Question: What form of chart is displayed?
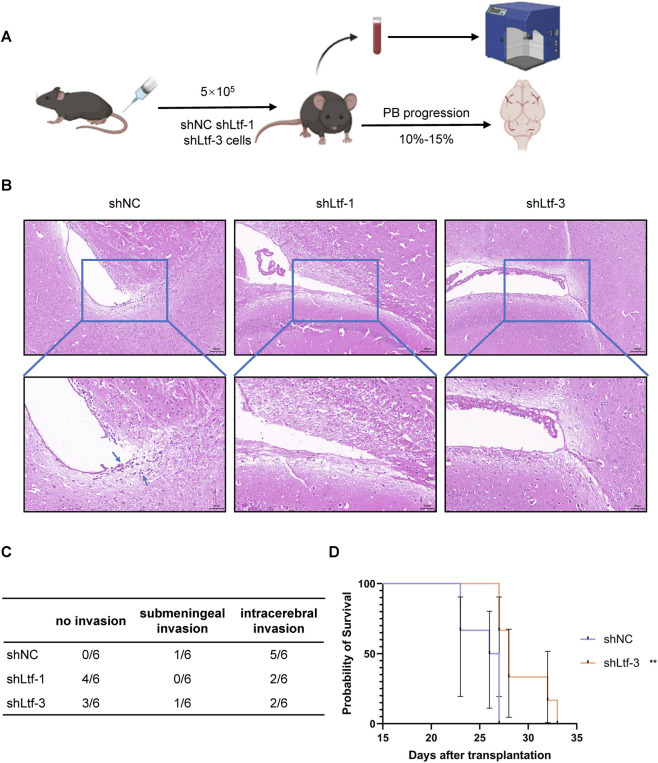
Answer: survival